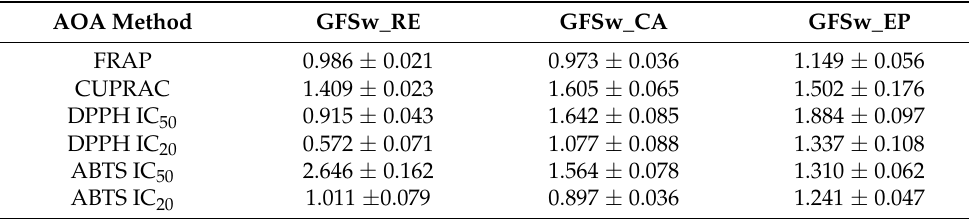
Table 7. Combination index (CI) between samples in AOA assays.